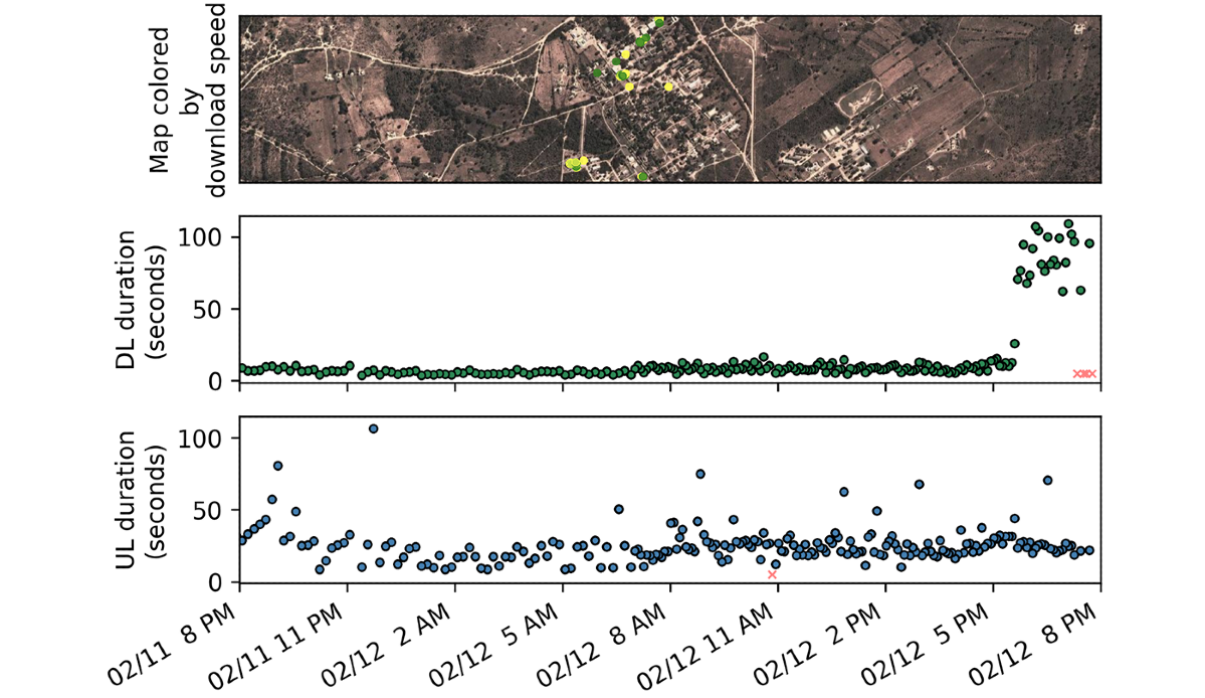
Figure 6. A representative 24-hour period of data collection: (top) download speed mapped by GPS coordinates, where download speed is denoted on a scale from green (high) to yellow (low); (middle) download duration over time; and (bottom) upload duration over time for the same period. Errors are denoted with red x symbols. DL: download; UL: upload